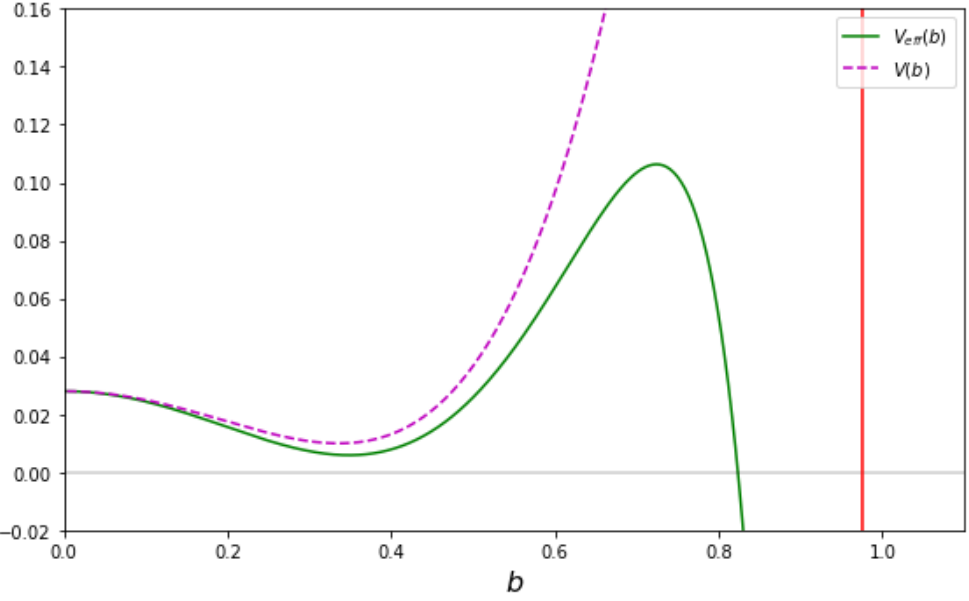
Figure 1. The effective potential (solid line) and bare potential (dashed line) for the parameter choice Λ = 0.71, R = 0.32 and ξ = 1.64 with d = 4. The red line on the right shows the limiting values for 8 d b for which the argument in the logarithmic term in the expression for the effective potential (51) is positive. Hence, in all realistic situations, the value of b will vary between these extreme